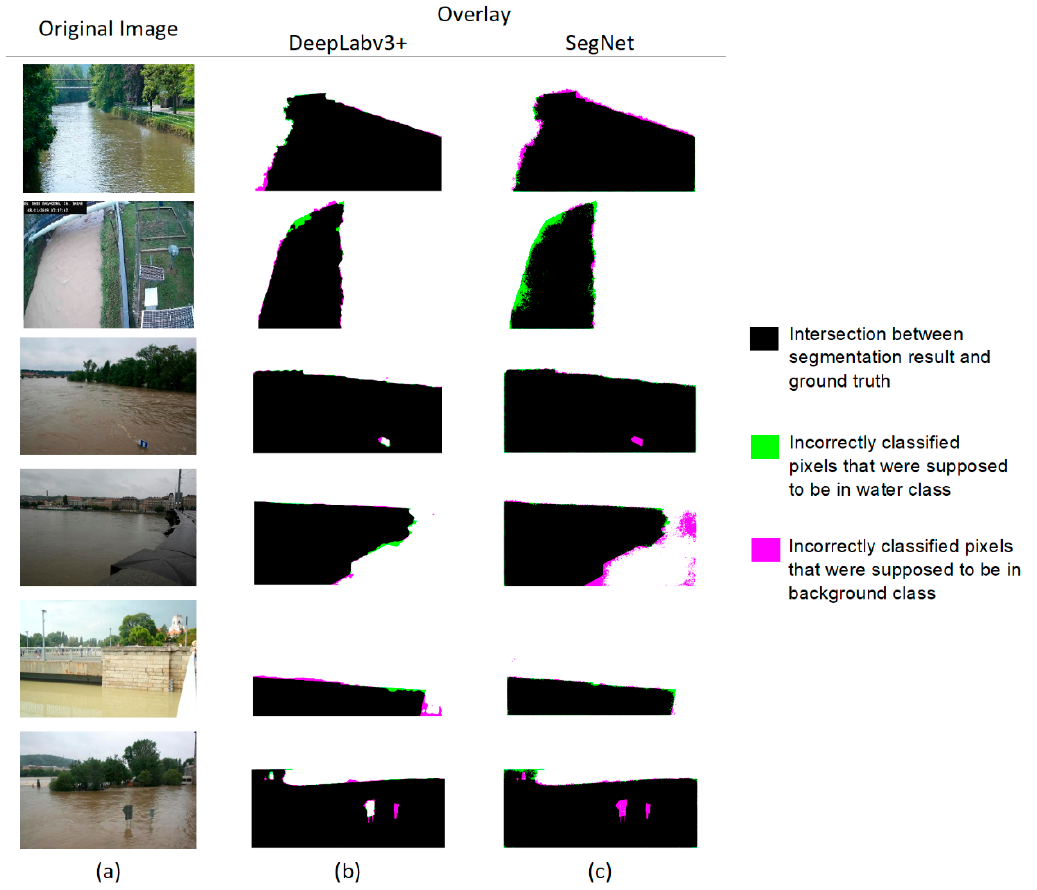
Figure 10. Comparisons between segmentation results and ground truth data are illustrated by overlay columns. ( a ) The original images ( b ) DeepLabv3+ prediction and ground truth ( c ) SegNet prediction and ground truth.